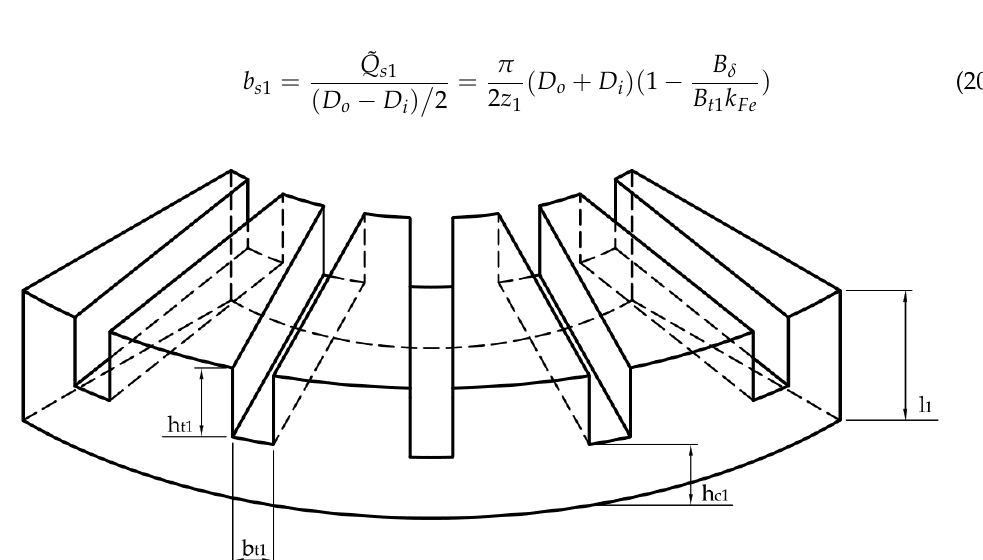
Figure 3. Stator teeth in